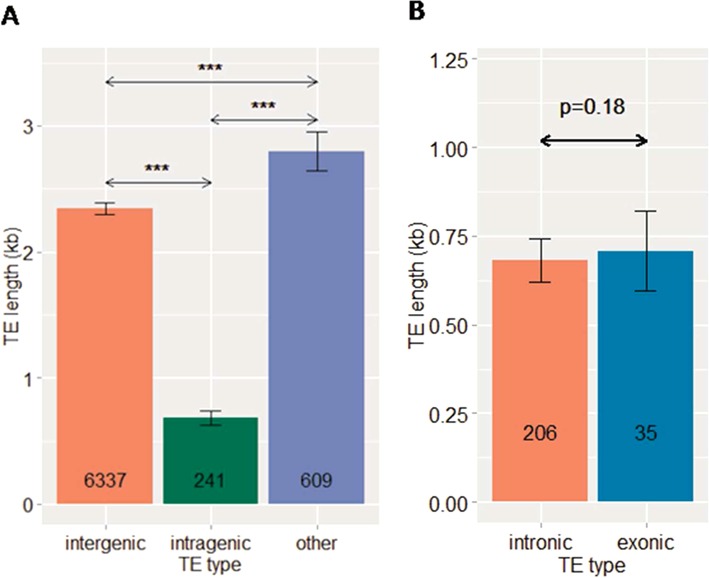
Size difference between intergenic, intragenic, and other TEs (A), and between intronic and exonic TEs (B). P values were given by the Mann-Whitney U (MWU) test. (***) corresponds to P < 0.0005. Numbers inside bar plots indicate the total numbers of TEs in each category. Error bars represent mean ± SE.